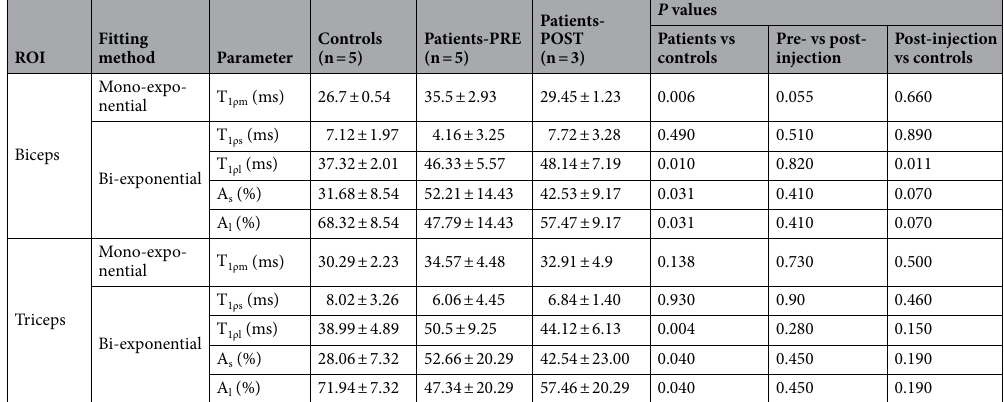
Table 1. Summary of mono-exponential and bi-exponential T 1ρ mapping results. Mean T 1ρ values (± SD) for mono-exponential (T